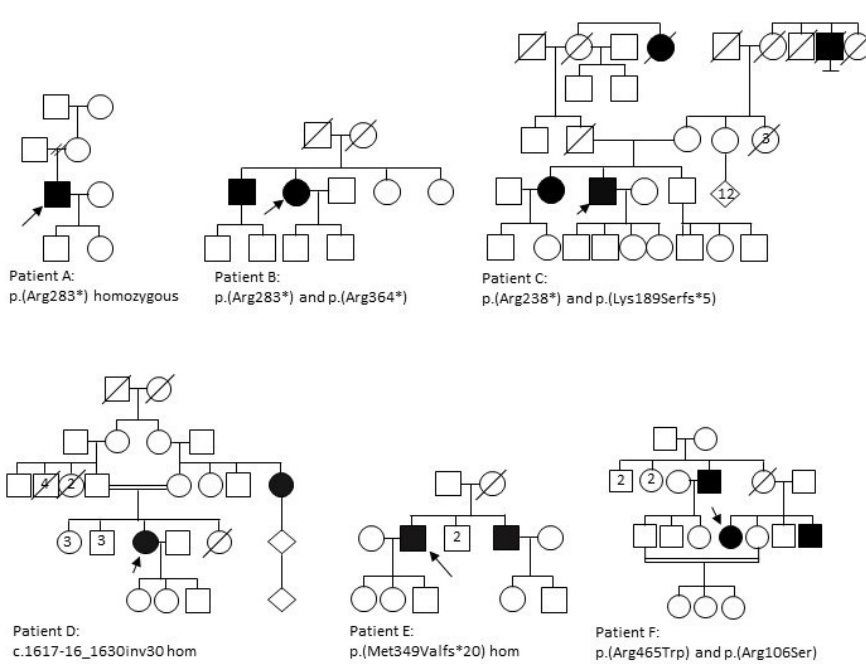
Figure 2. Pedigrees of families. Arrows indicate the proband and filled circles and squares represent affected females and males respectively.